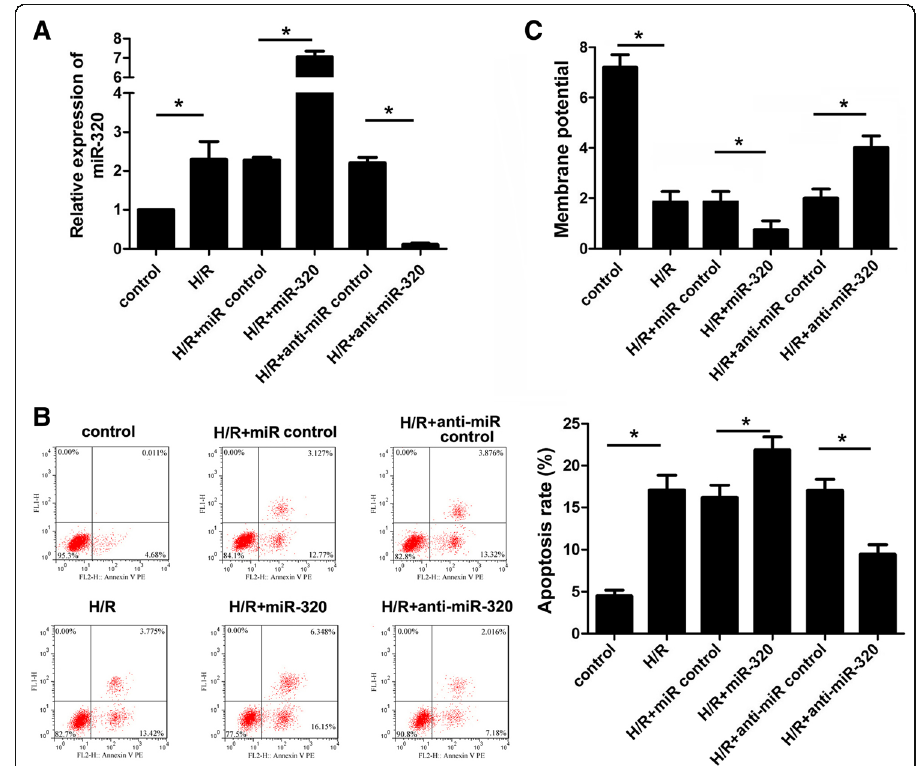
Fig. 2 MiR-320 promoted cardiomyocyte apoptosis induced by H/R and enhanced the loss of the mitochondrial membrane potential. a The relative levels of miR-320 normalized to U6 in H9c2 cells subjected to H/R were detected after the cells were transfected with miR-320, anti-miR-320 or the respective control using qRT-PCR. b Flow cytometry was used to investigate the apoptosis of H9c2 cells. The corresponding representative micrographs are located on the left. c The effect of miR-320 on the mitochondrial membrane potential in cardiomyocytes was detected. * P <